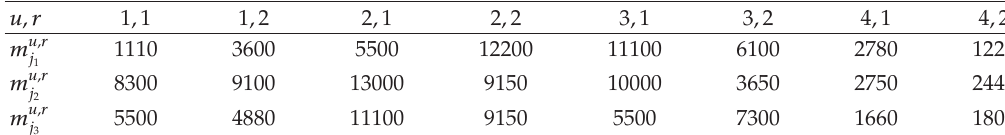
Table 3: The value of e u,r